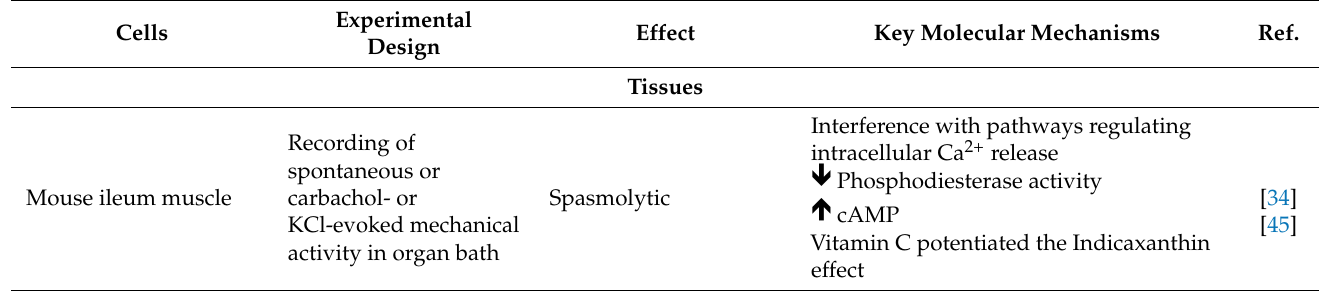
Table 5. Activity of Indicaxanthin in C. elegans. Table 3. Cont.